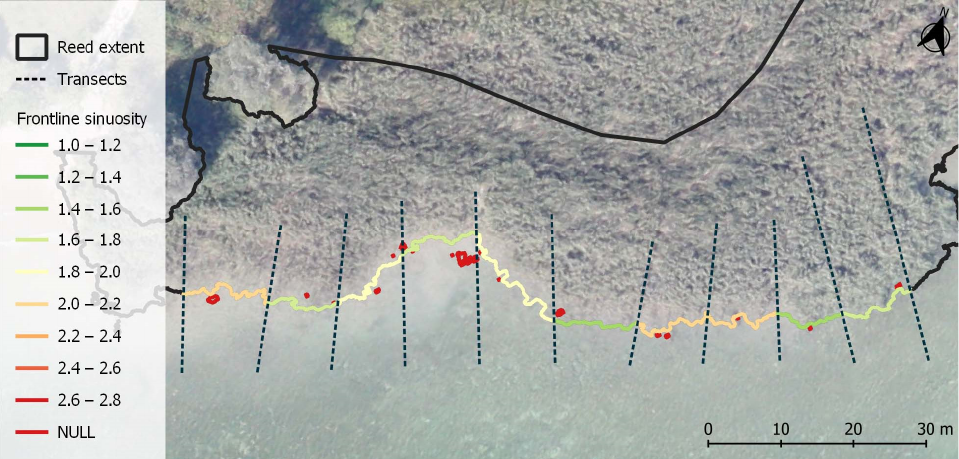
Figure 7. Frontline sinuosity at AOI 6. NULL values represent holes in or isles within in-situ identified aquatic reed patches. Table 2. Accuracy assessment showing the comparison between classified reed extent areas and reference data.